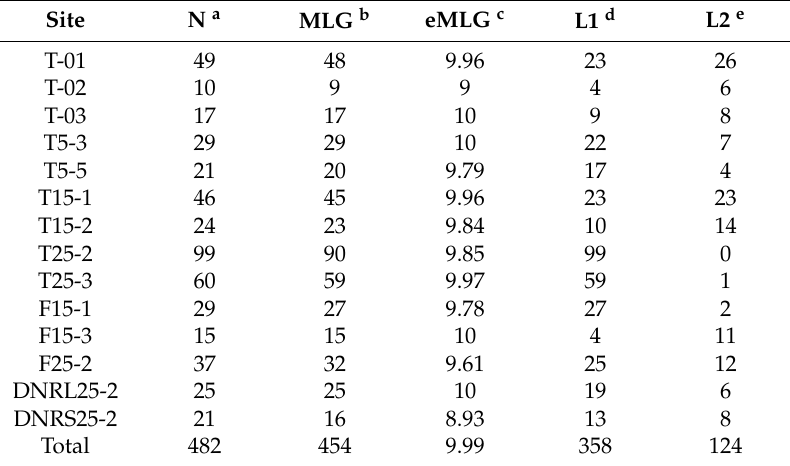
(expected number of multilocus genotypes in a rarefied sample of 10 isolates); d L1 = abundance of